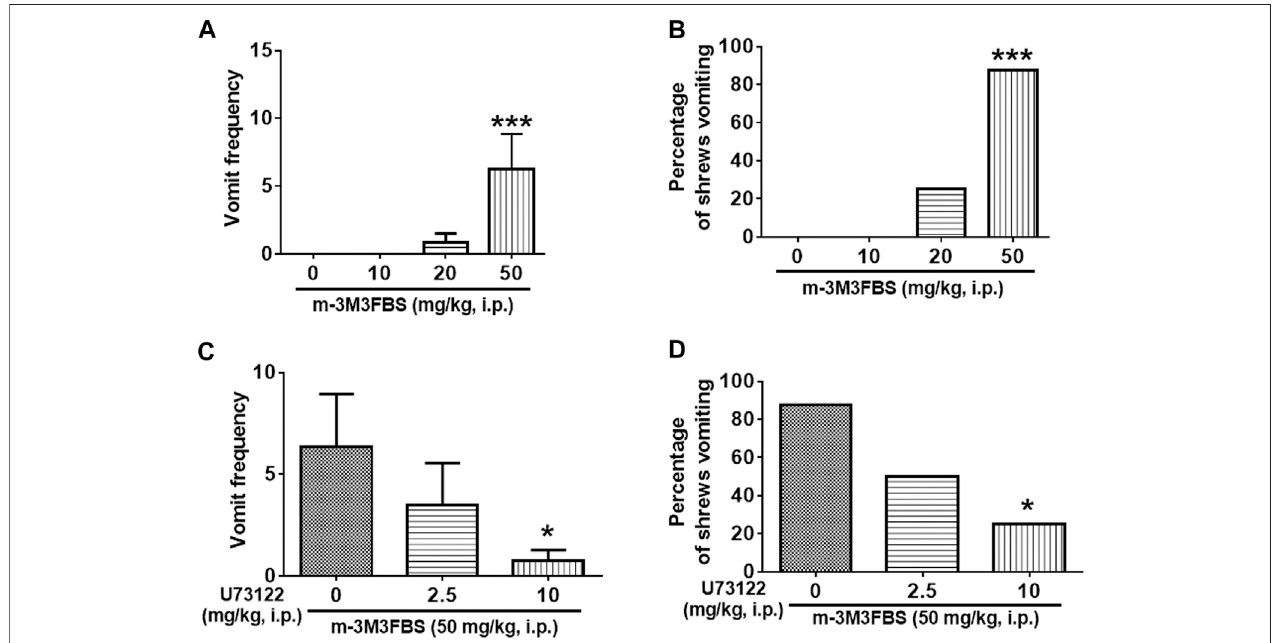
FIGURE 1 | The Proemetic effects of the PLC activator m-3M3FBS and the corresponding antiemetic ef fi cacy of the PLC inhibitor U73122 in least shrews. (A,B) Different groups ofleast shrews were given varying doses ofm-3M3FBS (i.p., n (cid:1) 8 shrews per group). Emetic parameters were recorded for the next 2 h. (C,D) In drug interaction studies, different groups of least shrews were given an injection (i.p.) of either the corresponding vehicle, or varying doses of U73122, 30 minutes prior to an injectionofm-3M3FBS (50 mg/kg,i.p.),andwereobservedforthenext2 h. (A,C) ThefrequencyofemesiswasanalyzedwithKruskal-Wallisnon-parametric one- wayANOVAfollowedbyDunnett ’ sposthoctestandpresentedasmean ± SEM. (B,D) Percentageofshrewsvomitingwasanalyzed withchi-squaretestandpresented as mean. * p < 0.05, *** p < 0.001vs. 0 mg/kg.